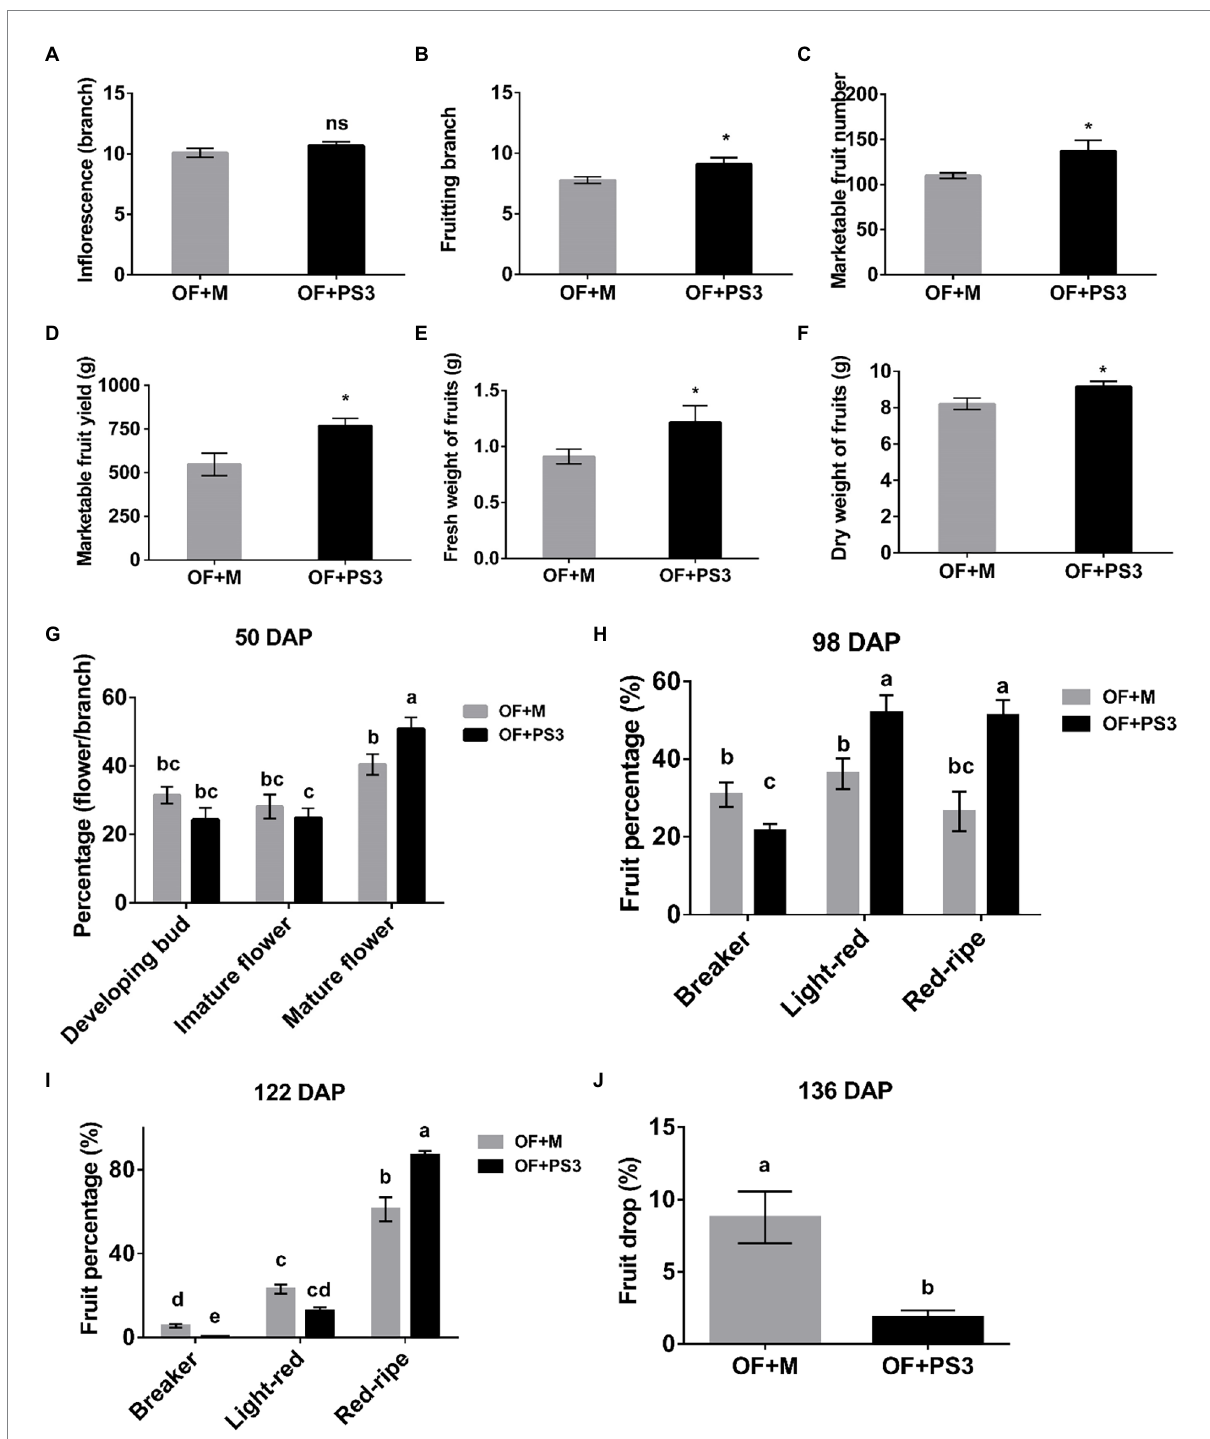
FIGURE 1 Effects of Rhodopseudomonas palustris PS3 on grafted tomato vegetative and reproductive growth traits. (A) Number of inflorescence branches. (B) Number of fruiting branches. (C) Marketable fruit numbers. (D) Marketable fruit yield. (E) Fresh weight of fruits. (F) Dry weight of fruits. (G) Flower development for a the first branch at various stages 50 days after planting (DAP). (H) Fruit color transformation for the first–sixth branches at 98 DAP. (I) Fruit color transformation for the first–sixth branches at 122 DAP. (J) Fruit drop percentage for all harvested branches of grafted tomato at 136 DAP. OF + M: applying the plant-based organic fertilizer and new PNSB medium in the soil; OF + PS3: applying plant-based organic fertilizer and PS3 inoculant in the soil. DAP represents days of planting in panels (G–J) . All results are expressed as the mean ± SE. The statistical test was based on Welch’s t -test for panels (A–F) (ns, p ≥ 0.05; *, p < 0.05) and one-way ANOVA followed by Tukey’s post hoc test for panels ( G–J ; letters above means indicate significant differences among treatments at a threshold of p <